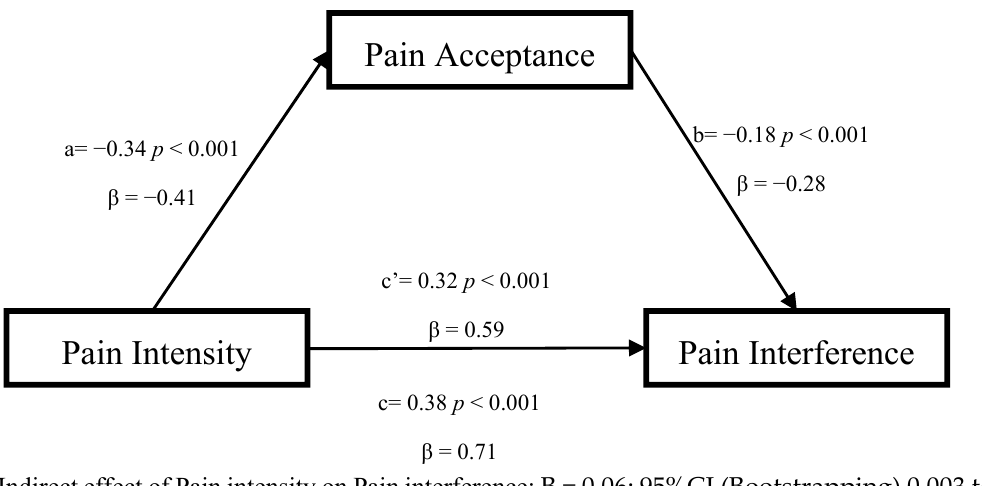
Figure 2. Linear regression results for the mediation model, adjusted by age and gender, with pain acceptance as the mediator between pain intensity and pain interference.